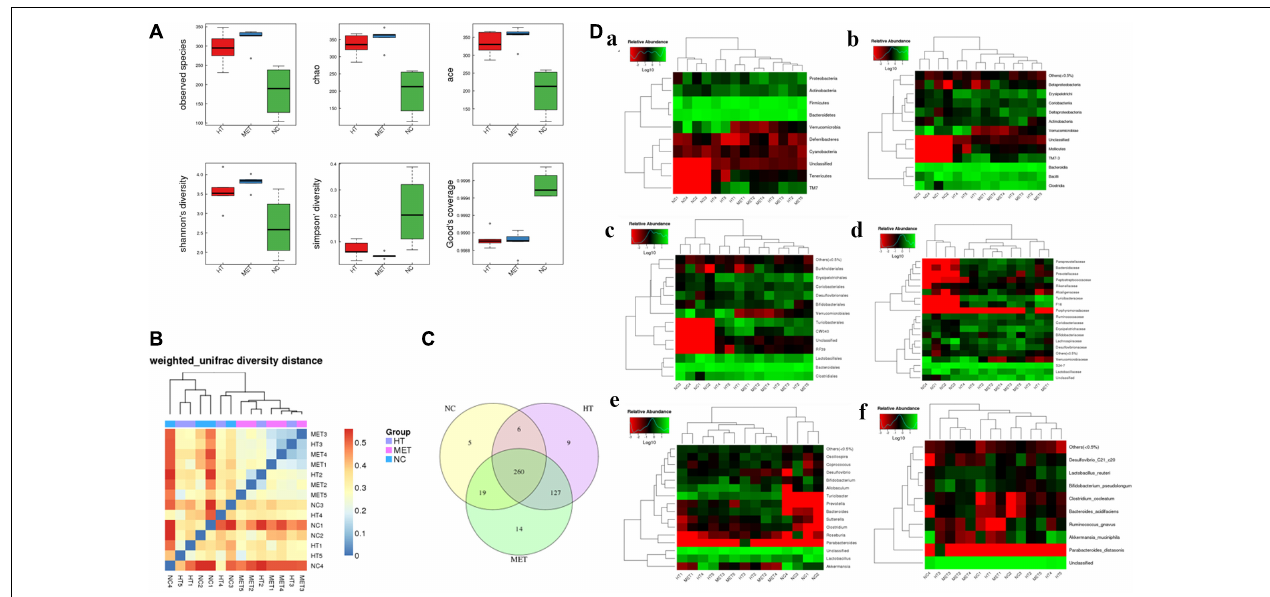
FIGURE 6 | Differences in intestinal flora detected by 16s-RNA sequencing. (A) Differences in observed species, chao index, ace index, Shannon’s diversity, Simpson’ diversity and Good’s coverage between groups. (B) Weighted unifrac diversity distance. (C) Venn diagram of flora between groups. (D) Species profiling at different levels, (a) phylum classification level, (b) class classification level, (c) order classification level, (d) family classification level, (e) genus classification level, and (f) species classification